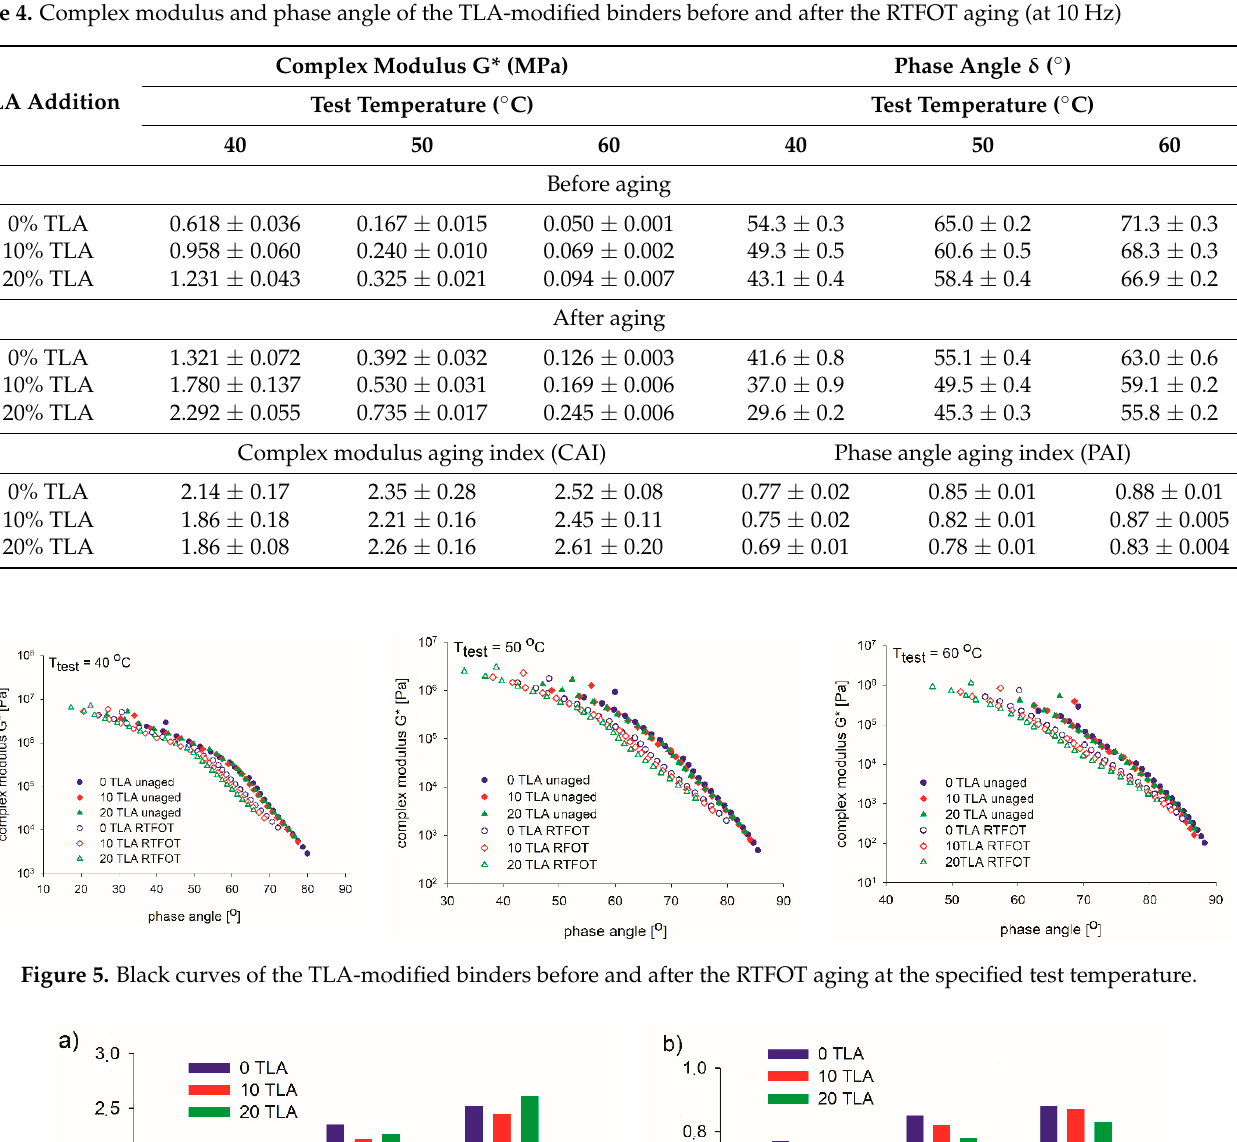
Table 4. Complex modulus and phase angle of the TLA-modified binders before and after the RTFOT aging (at 10 Hz)